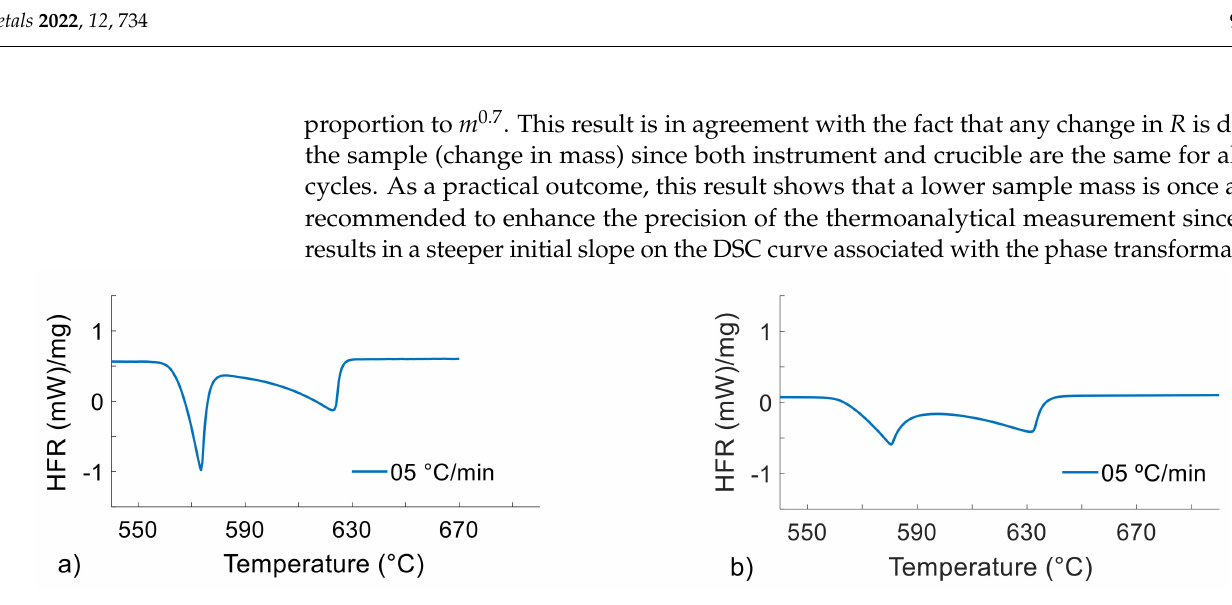
Figure 4. DSC heat flow rate ( y -axis) vs. temperature ( x -axis) curves during melting of the Al 4 Si 4 Zn alloy at 5 ◦ C/min with DSC sample masses of 20 ( a ) and 200 ( b ) mg.